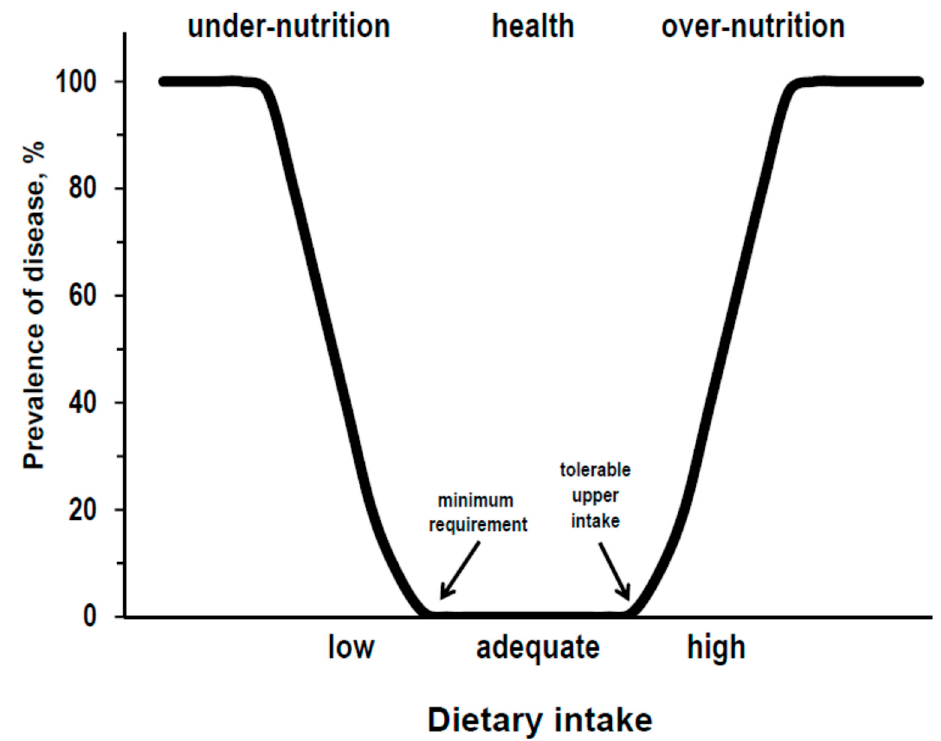
Figure 1. Theoretical relationship for essential nutrients between the level of dietary intake and disease prevalence.